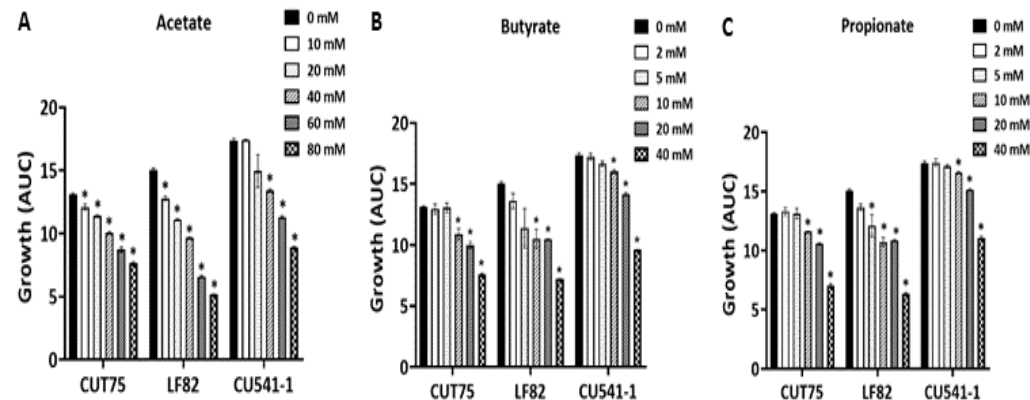
Figure 4. Inhibition of E. coli growth by individual SCFA. E. coli was grown in LB broth at pH = 6.5, with added individual SCFA as shown in the figures. The osmolarity was balanced out with NaCl. Growth conditions were the same as for Figure 1. Data from three independent experiments; Mean ± SE. * p < 0.05.